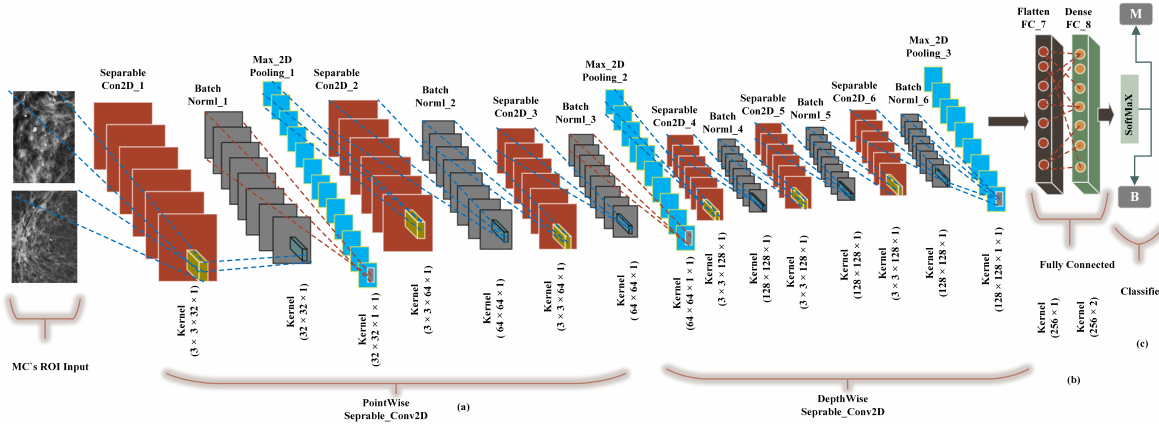
3 Separable2D convolutional layer performs × 2 max-pooling layer, ( b ) A ×